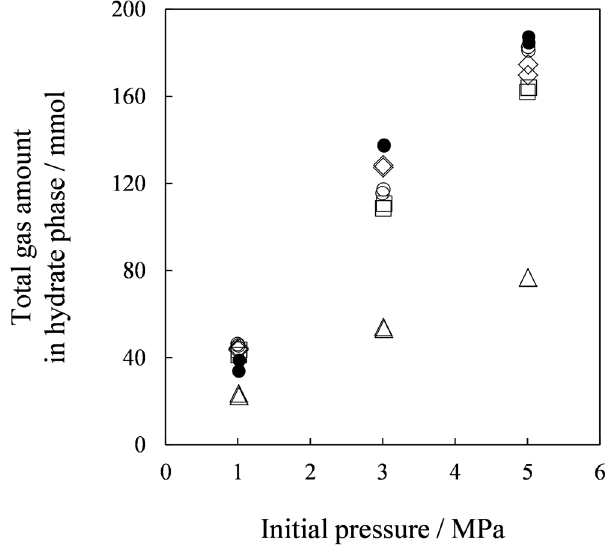
Figure 2. Gas amount captured by ionic clathrate hydrates. The symbols show ionic guest substances: ● , TBAB with w = 0.320; ○ , TBAB with w = 0.200; △ , TBAC with w = 0.200; □ , TBPB with w = 0.200; ◊ , TBPC with w = 0.200.